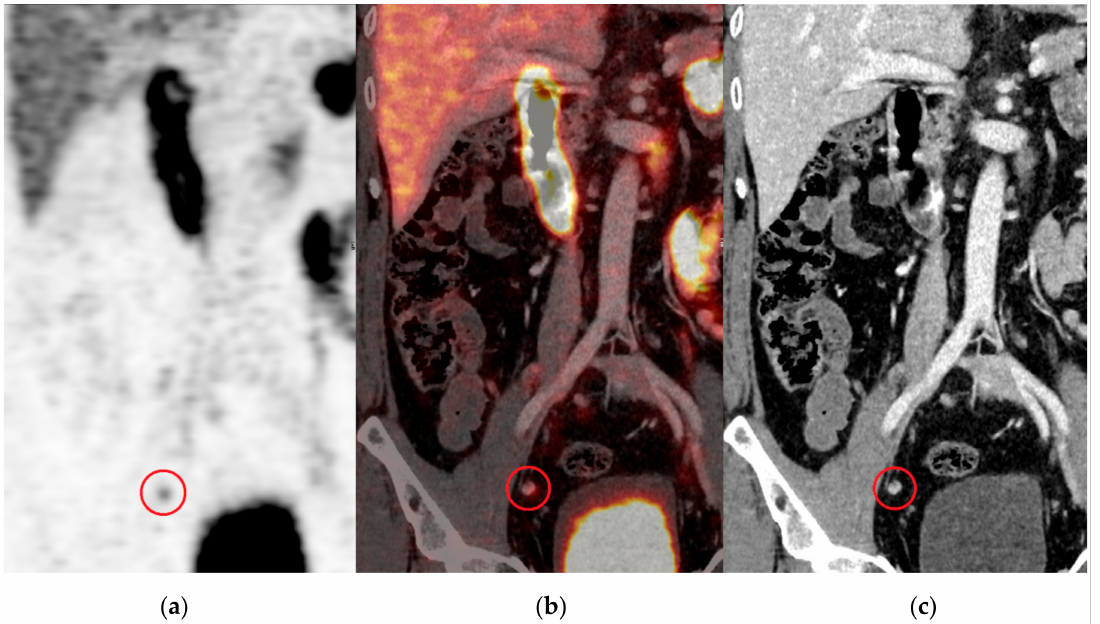
Figure 2. Coronal projections of ( a ) a PET, ( b ) PET-CT fusion and ( c ) CT using the OSEM reconstruction algorithm. An equivocal lymph node can be seen in the pelvis (encircled). Note the similar signal intensity of the lymph node compared to the liver uptake.